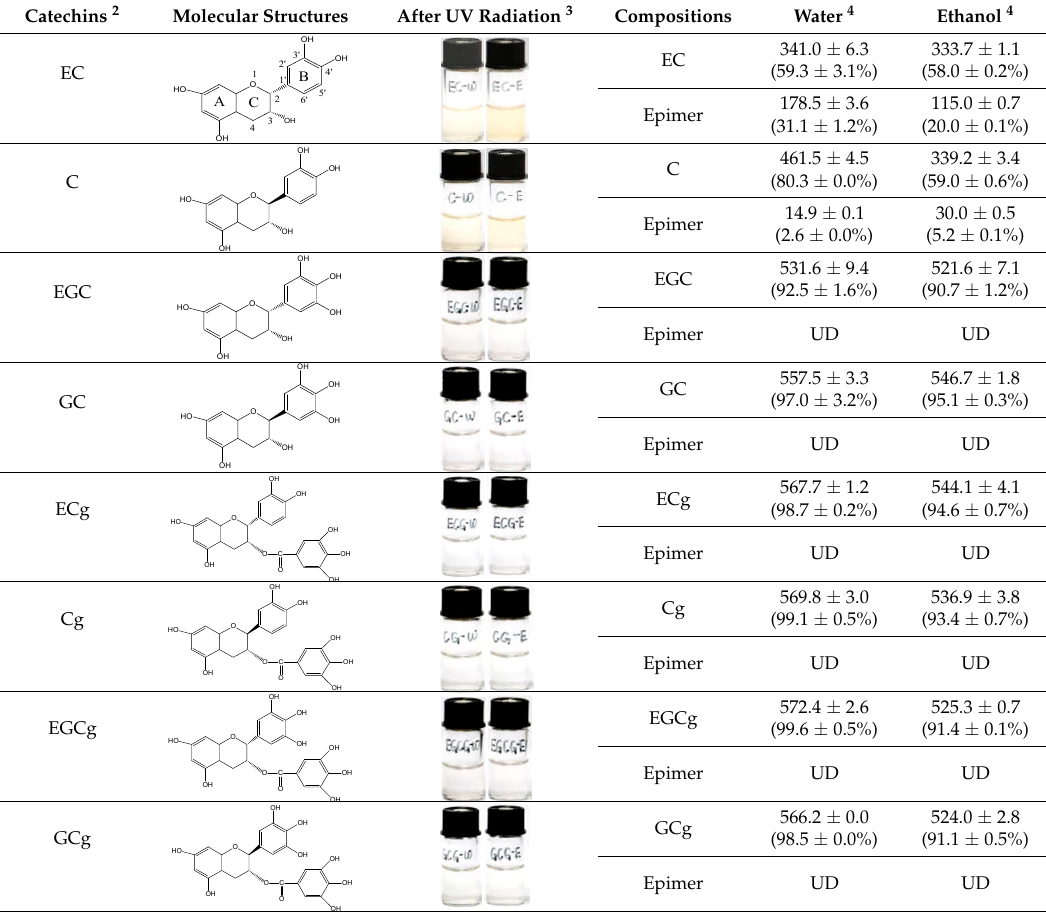
Table 1. The photostabilities of eight catechins under ultraviolet B (UVB) radiation ( μ M) 1 . Catechins 2 Molecular Structures